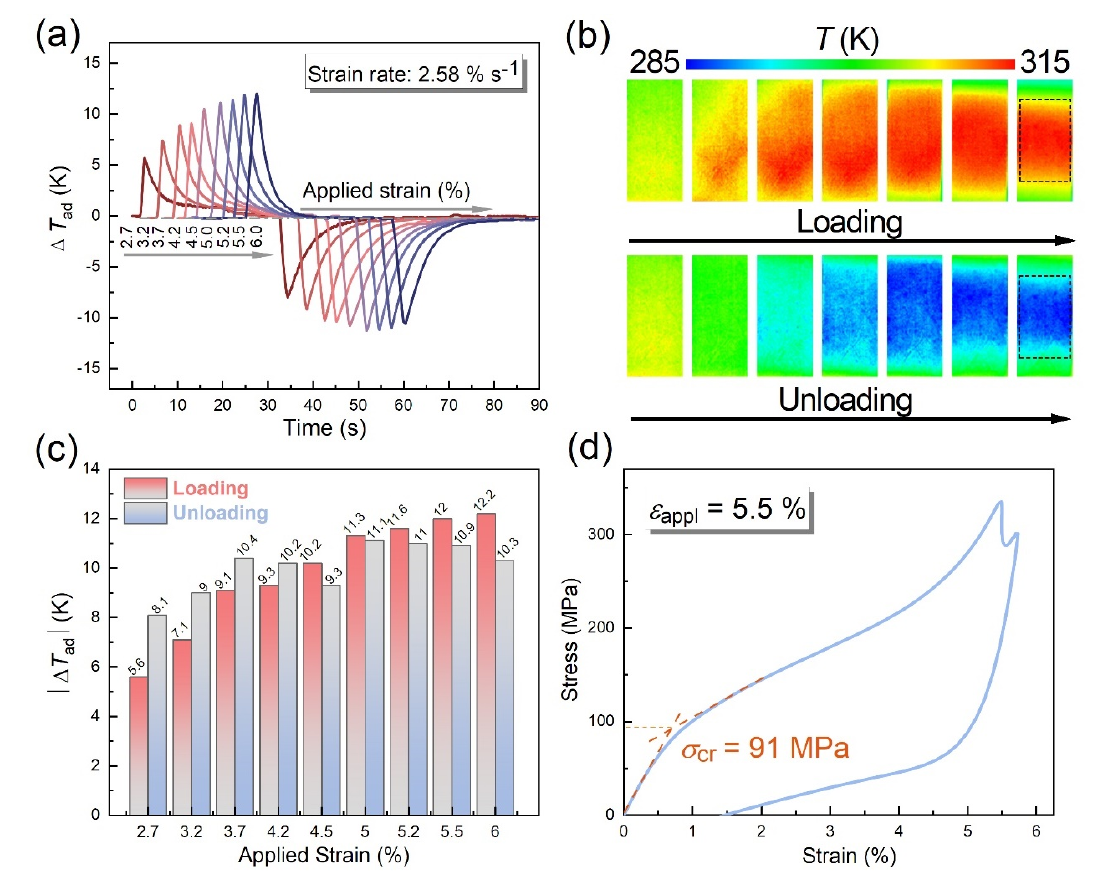
Figure 3. ( a ) ∆ T ad parameter as a function of time under different applied strains with a strain rate of 2.58% s − 1 at 303 K. The temperature–time profile is obtained from the dashed frame areas in the IR spectrograms. ( b ) The IR images at the applied strain of 6.0%. ( c ) The average ∆ T ad values at various compressive strains during loading and unloading. ( d ) The stress–strain curve under applied strain of 5.5%.